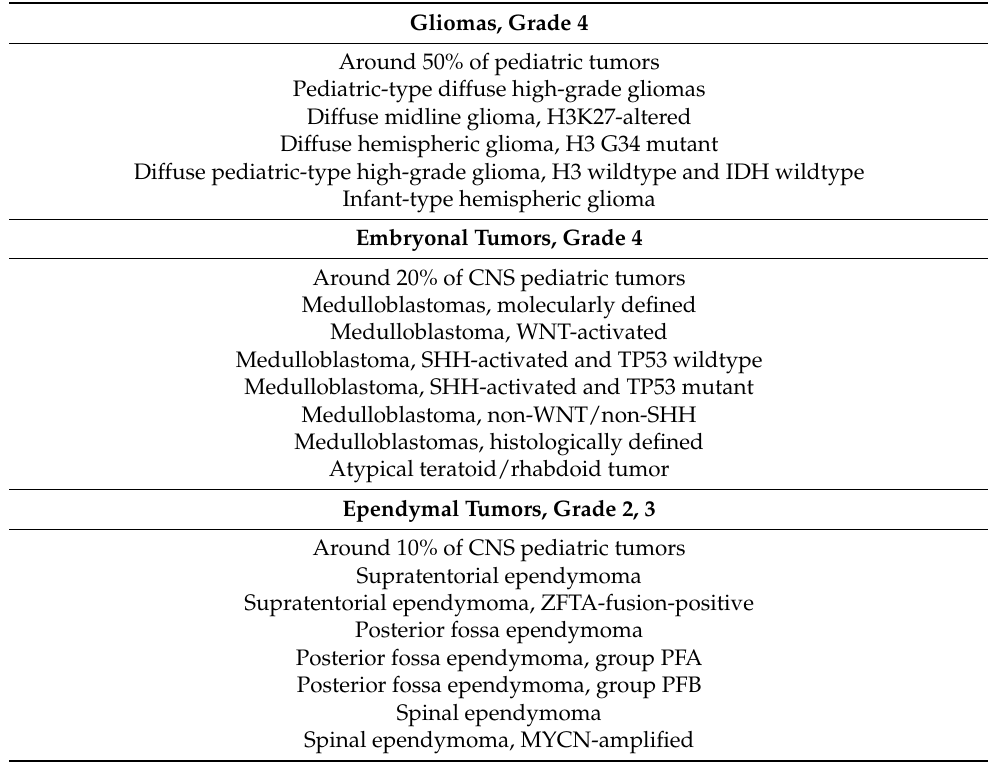
Table 1. WHO-recognized grade 3 and grade 4 primary pediatric brain